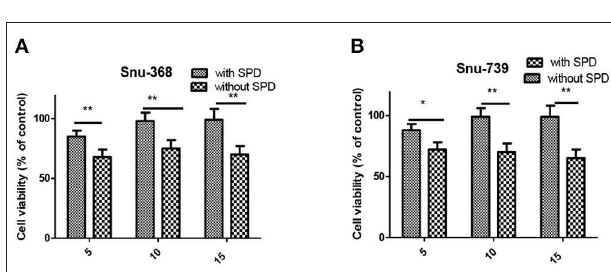
FIGURE 6 | Cell viability of Snu-368 (A) and Snu-739 (B) cells after treatment with 5c was determined with and without Spd (50 µ M). *** P <